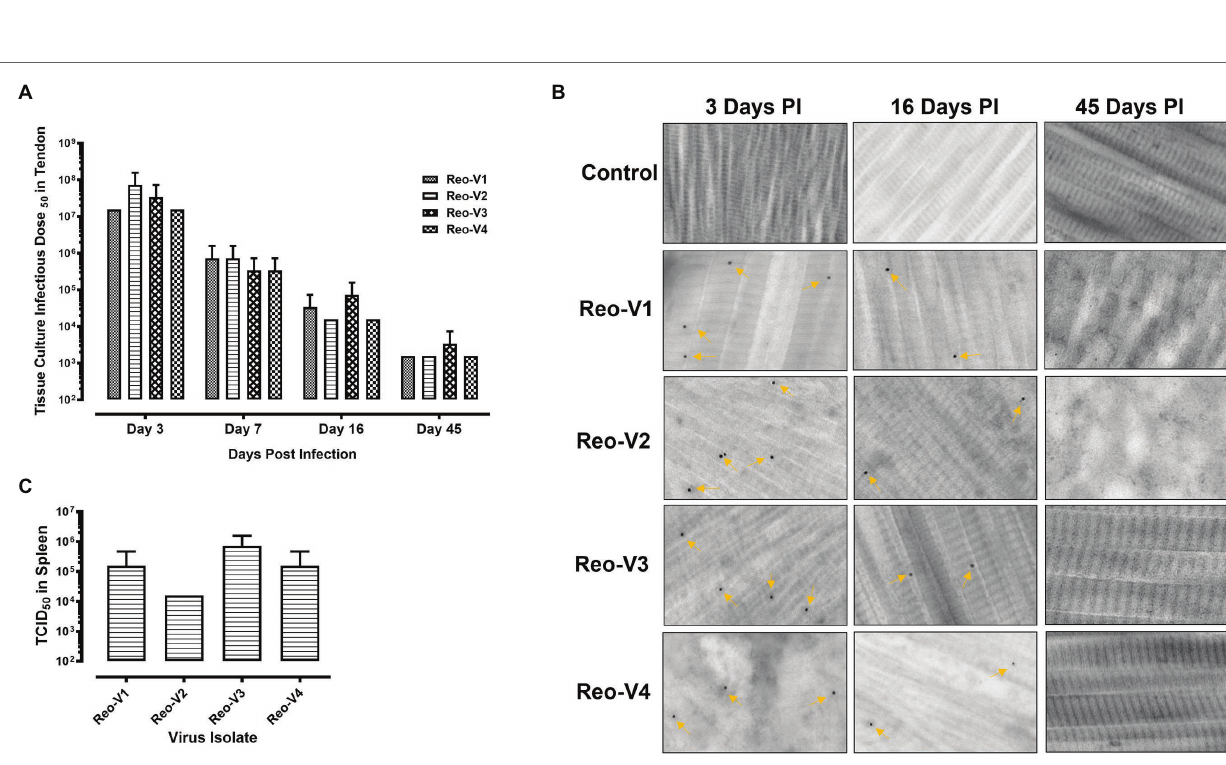
FIGURE 4 | Detection of ARVs [i.e., Reo-V1 (Cluster-5), Reo-V2 (Cluster-4), Reo-V3 (Cluster-2), or Reo-V4 (Cluster-6)] in the tendon and spleen tissues of birds at day 3, 7, 16 & 45 post-infection. (A) Tissue culture infectious dose (TCID) 50 of ARVs in the tendon tissues of infected birds at different times post-infection. A two- way ANOVA analysis was performed to estimate the differences in virus titers between the different groups over different days post-infection [ p = 0.012 (between days post-infection); p = 0.432 (between groups at each time point)]. (B) Detection of ARVs in tendon tissues by immunogold-transmission electron microscopy (IG-TEM) at the indicated time points PI (post-infection). Immunogold labelled viral particles (i.e., black dots) are indicated by yellow arrows. (C) TCID 50 of ARVs in the spleen tissues at day 3